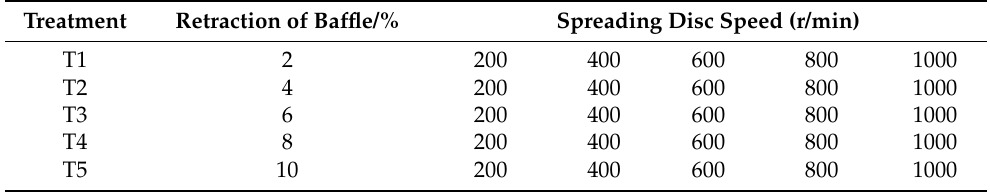
Table 3. Indoor test gradient